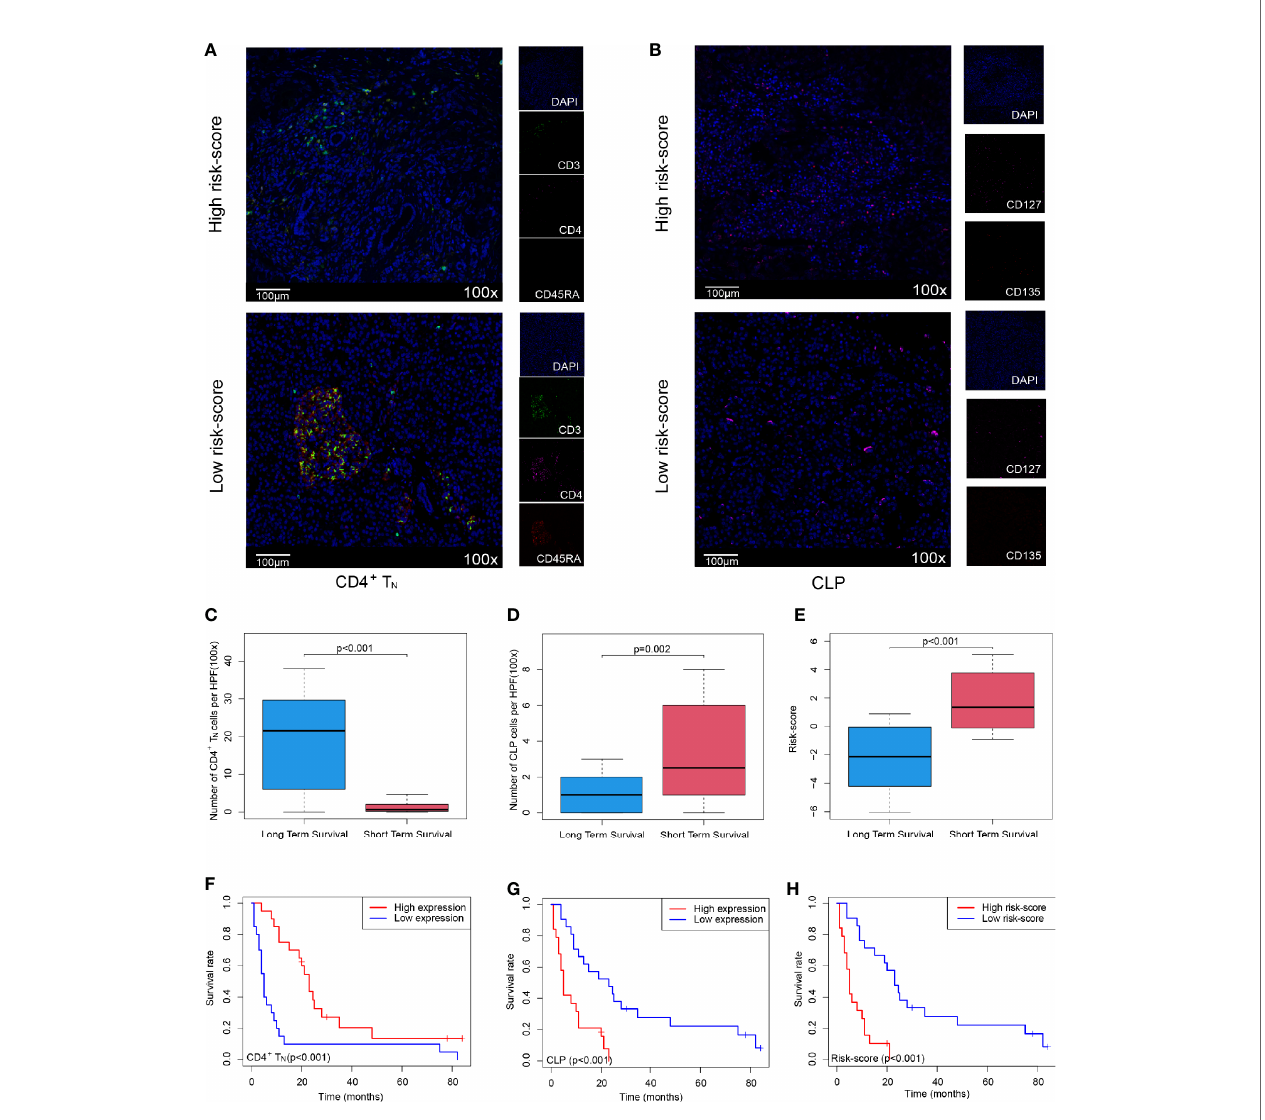
FIGURE 3 | Validating the Cox model can improve the sensitivity of predicting OS in Peking2020 cohort. (A, B) Multiplex immuno fl uorescence analyses on CD4 + T N and CLP intratumoral in fi ltration in Peking2020 cohort (n = 40). CD4 + T N depicts co-localization staining for CD3 + , CD4 + , and CD45RA + . CLP depicts co-localization staining for CD127 + and CD135 + (randomly select three fi elds at least). (C – E) Box plot depicts the level of CD4 + T N , CLP, and risk-score between long-term survival and short-term survival. (F – H) OS in CD4 + T N , CLP, and risk-score high vs . low-in fi ltrating cell/risk-score patients depicted by KM plots in Peking2020 cohort respectively. OS, overall survival; KM, Kaplan – Meier; CLP, common lymphoid